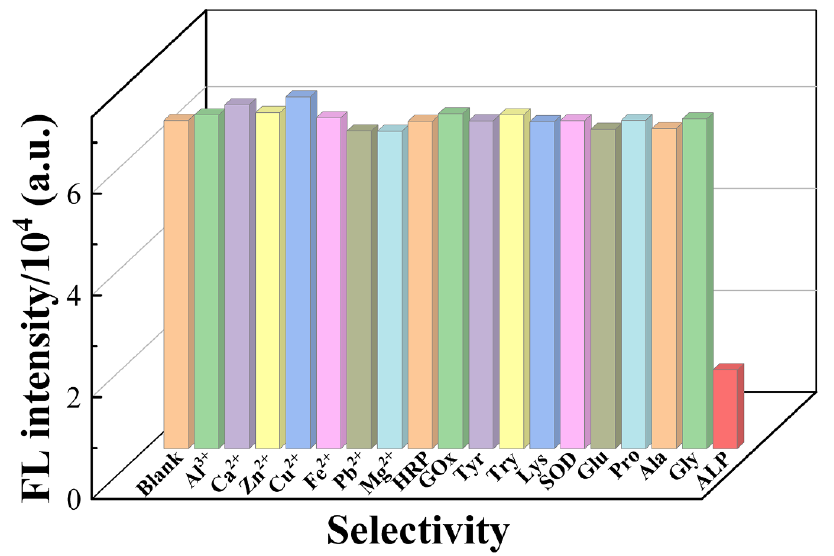
Figure 9. The selectivity in the fluorescent “turn - off” detection of ALP activity using Ag -TPA CPNs. The concentrations of the various enzymes (HRP, GOx, Tyr, Try, Lys, and SOD) equal 1000 mU/mL. The concentrations of the amino acids (Glu, Pro, Ala, Gly) equal 100 μ M. The concentrations of the different metal ions (Al 3+ , Ca 2+ , Zn 2+ , Cu 2+ , Fe 2+ , Pb 2+ , Mg 2+ ) equal 100 μ M. ALP: alkaline phosphatase; HRP: horseradish peroxidase; GOx: glucose oxidase; Tyr: tyrosinase; Try: trypsin; Lys: lysozyme; SOD: superoxide dismutase; Glu: glutamic acid; Pro: proline; Ala: alanine; Gly: glycine; c (ALP): 10 mU/mL; c (AA2P): 0.25 mM; Ag-TPA CPN solution: 50 μ L; λ ex : 320 nm; λ em : 490 nm. All error bars represent the standard deviation of three measurements.